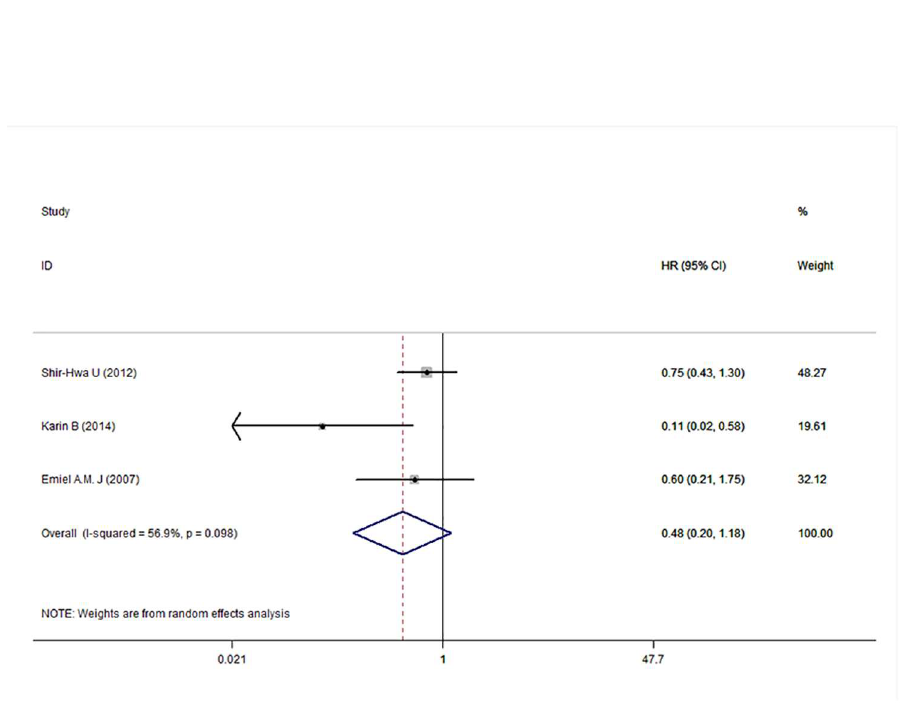
Fig 4. Meta-analysis of the overall pooled HR of studies for recurrenceof breast cancer. Forest plot showingno statistical significanceof associationbetweenp-mTOR expressionand recurrence-free survival of breast cancer patients from the random-effects